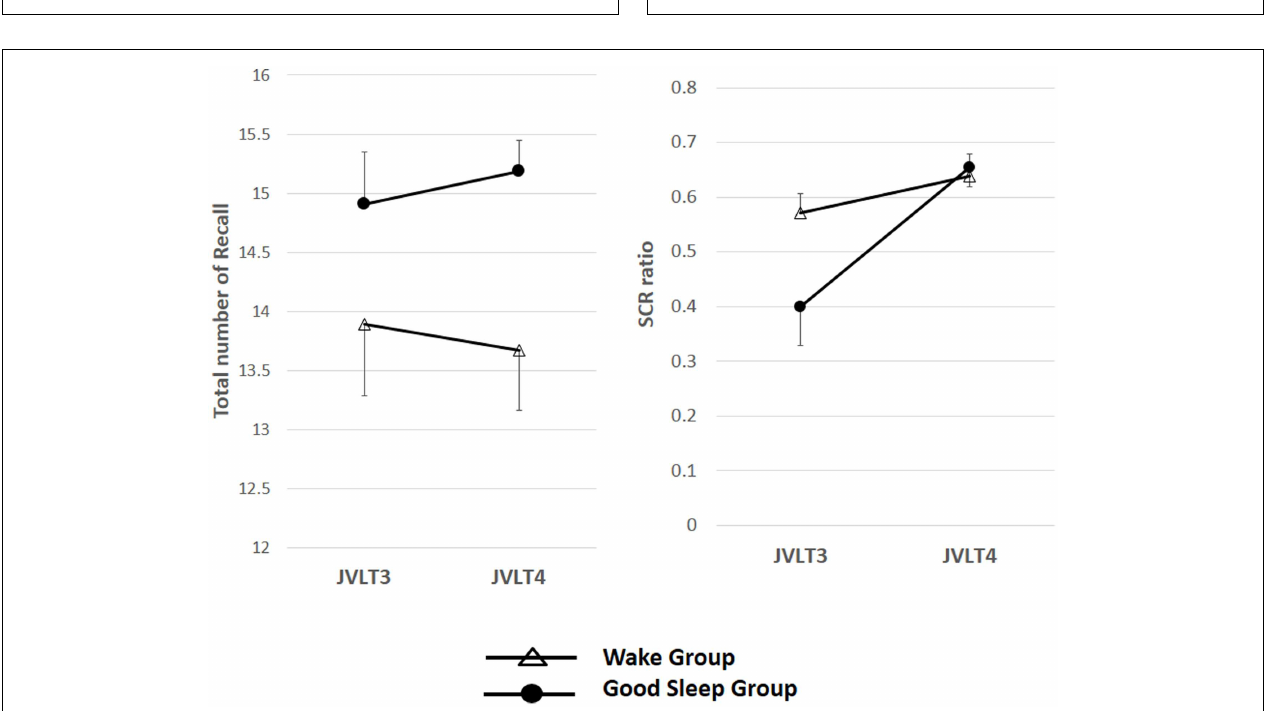
FIGURE 7 | SCR ratio for the fourth JVLT trial/SCR ratio for the third trial for the wake group and good sleep groups . * p < 0.05 by Mann–Whitney U -test.